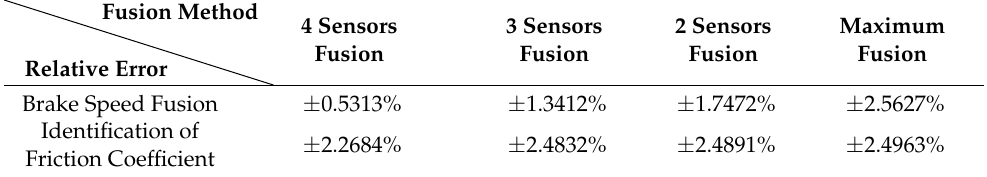
Table 3. Speed fusion errors and parameter identification errors.